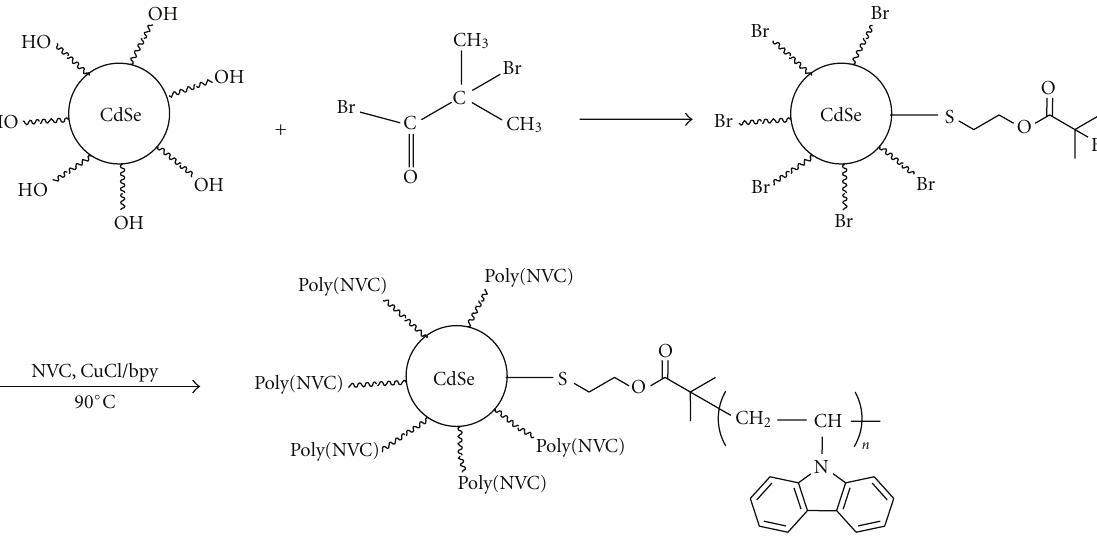
Scheme 16: Synthesis of CdSe-polymer composite by ATRP of